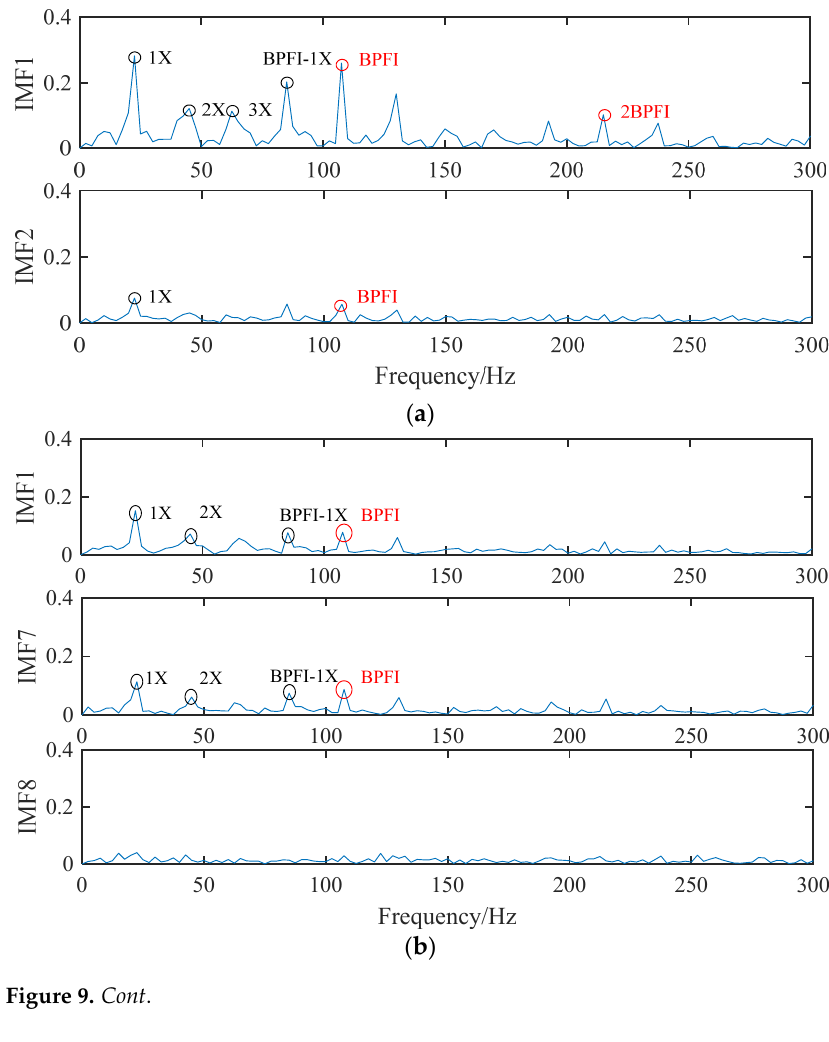
Figure 8. Correlation coefficients and variance contribution rates of IMF components with three different algorithms.